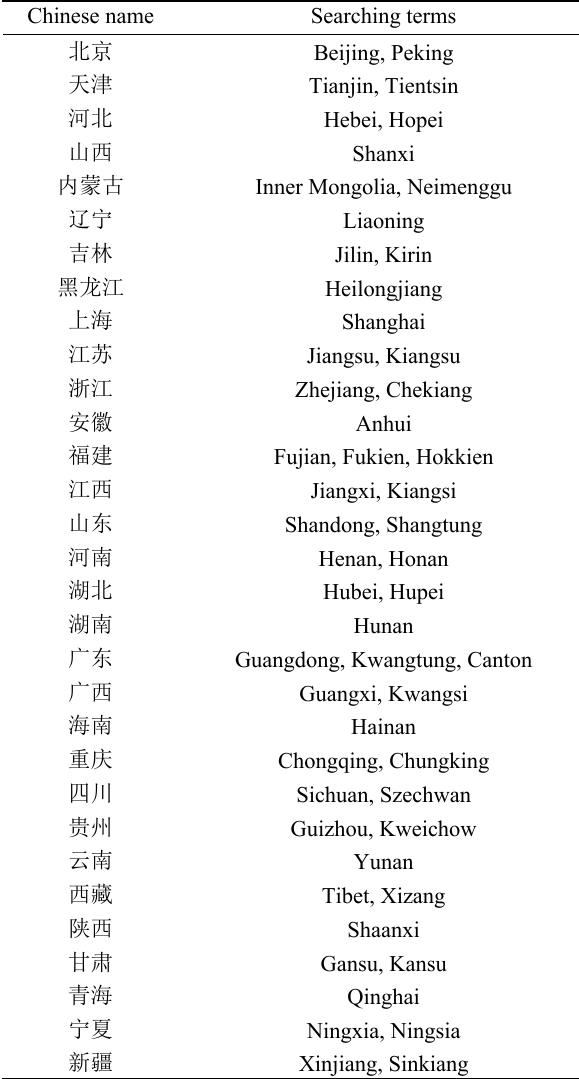
Table A1 Search terms for Chinese provincial-level